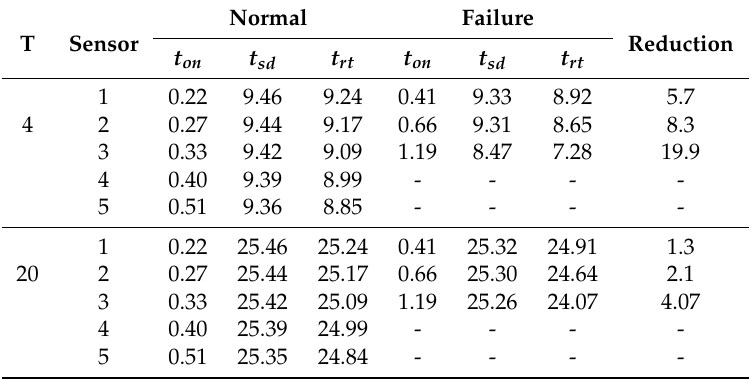
Table 4. Microcontroller powering, shutdown, and run times under normal and failure operations. Normal Failure T Sensor t